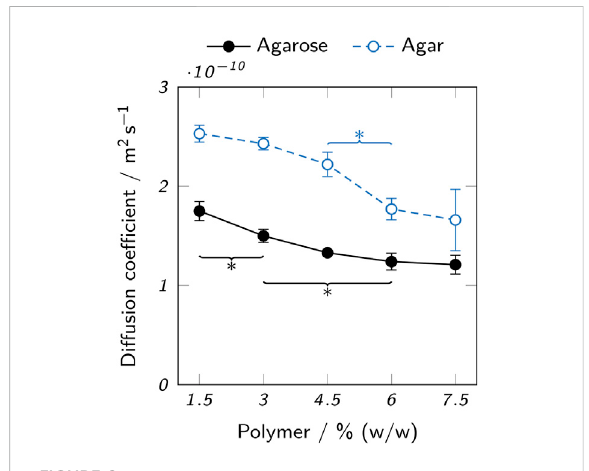
FIGURE 8 Diffusion coef fi cients of 5(6)-carboxy fl uorescein in low-melt agarose and agar hydrogels. The data points represent mean values ± standard deviation ( n = 3). For clarity, only signi fi cant differences to the nearest signi fi cantly different data points are highlighted by asterisks ( p <